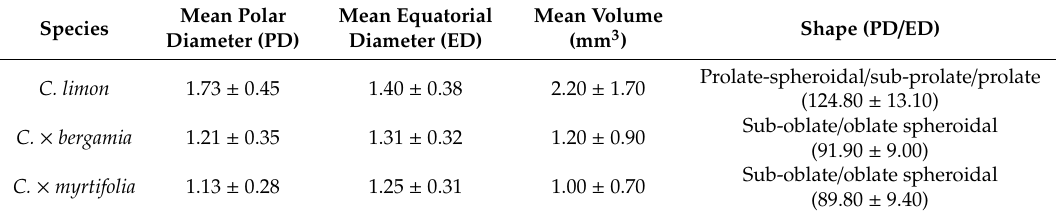
Figure 1. Cross section of Citrus limon peel. The exocarp is composed of two clearly distinguishable regions, the pigmented peripheral epicarp or flavedo, and the white middle layer called mesocarp or albedo. Enlarged oil glands are visible in the flavedo. Table 1. Morphometric measurements of oil glands from the peel of C. limon, C. × bergamia and C. ×